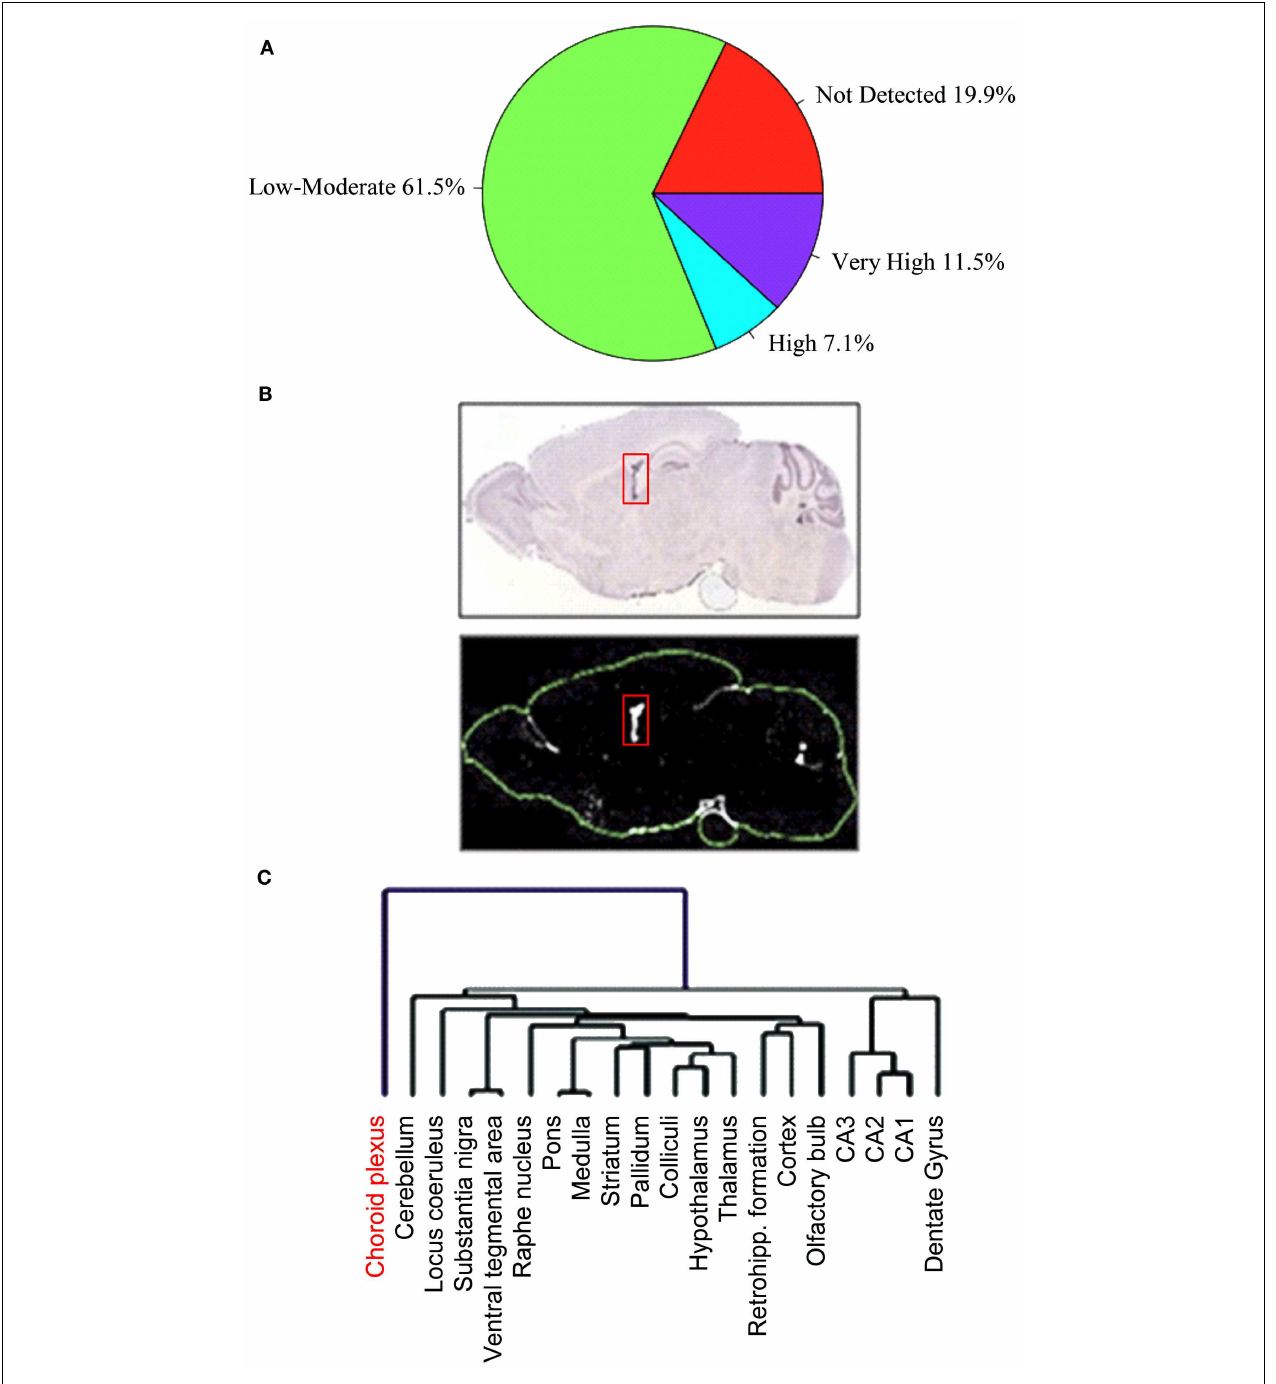
definition and calculation of the E value. Panels in (B) show the restricted localization of Slc26a11 ISH signals in the CP (structure is indicated by the red boxes).The upper panel represents ISH image and the lower panel is the expression mask generated from the ISH image. In (C) , a dendrogram of clustered brain regions (choroid plexus in red) is shown. Reproduced with permission from Dahlin et al. (American Society for Pharmacology and